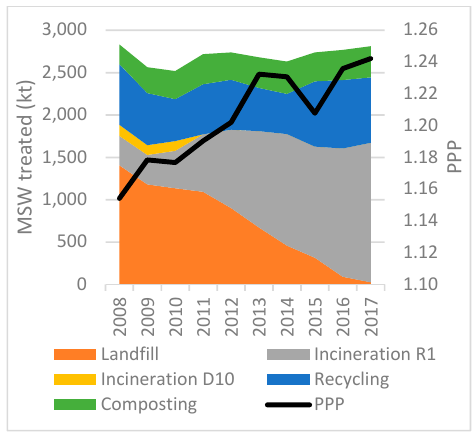
Figure 52. Waste treatment methods and PPP in Finland 2008–2017(European Statistics 2019b, 2019c).